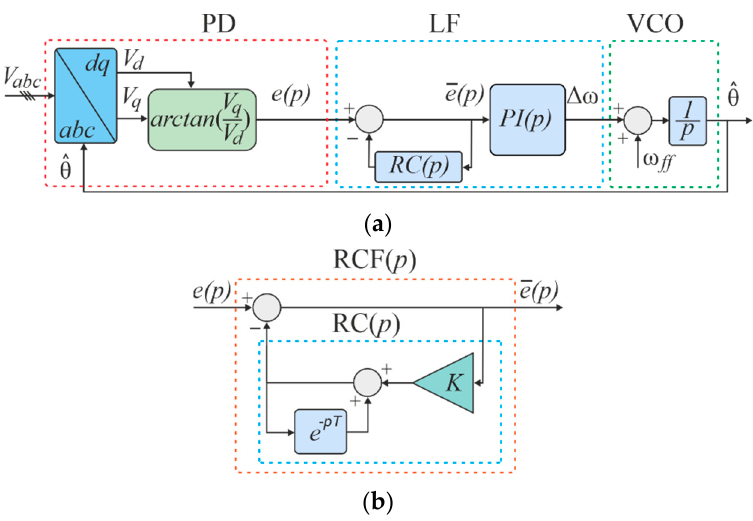
Figure 2. Block diagrams. ( a ) synchronous reference frame phase-locked loop (SRF-PLL) with initial modification; ( b ) repetitive disturbance rejector.